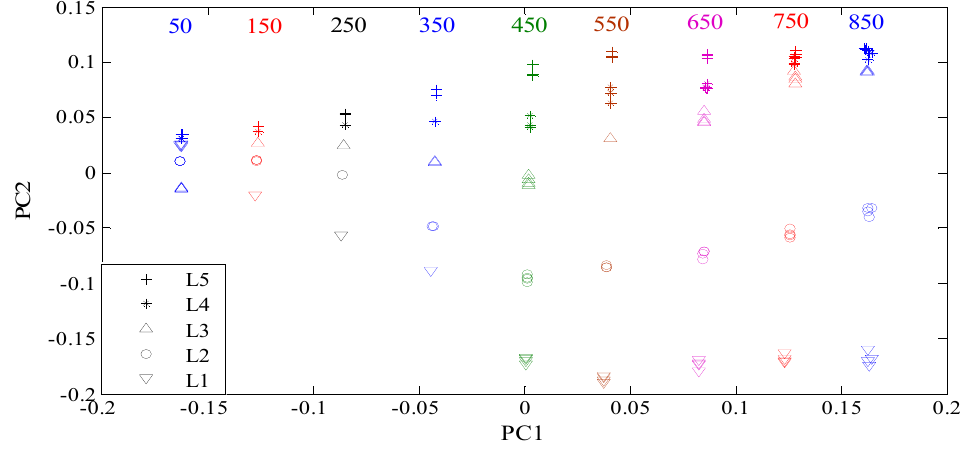
Figure 8. Features of the defects with different lengths.